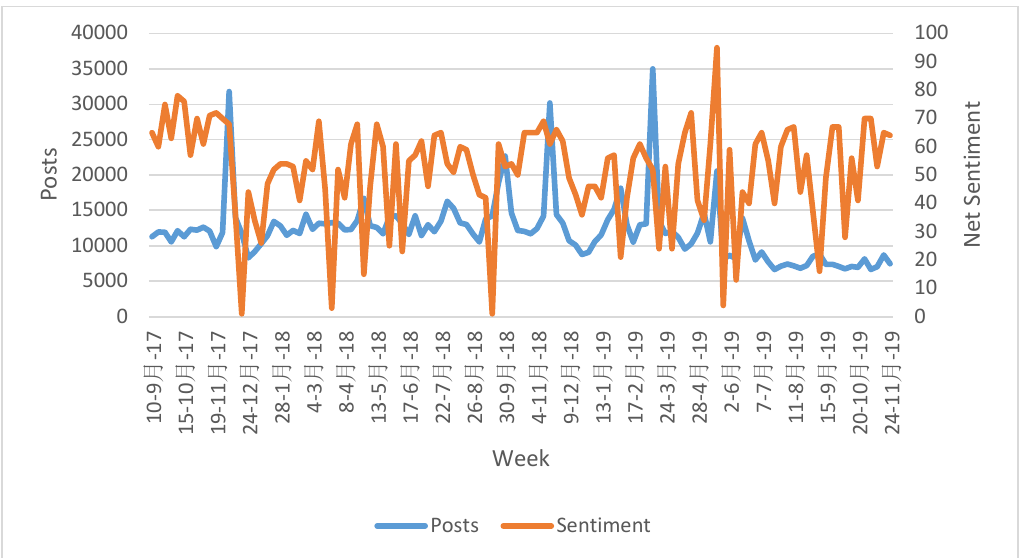
Figure 1. Weekly posts and net sentiment from September 2017 through November 2019.